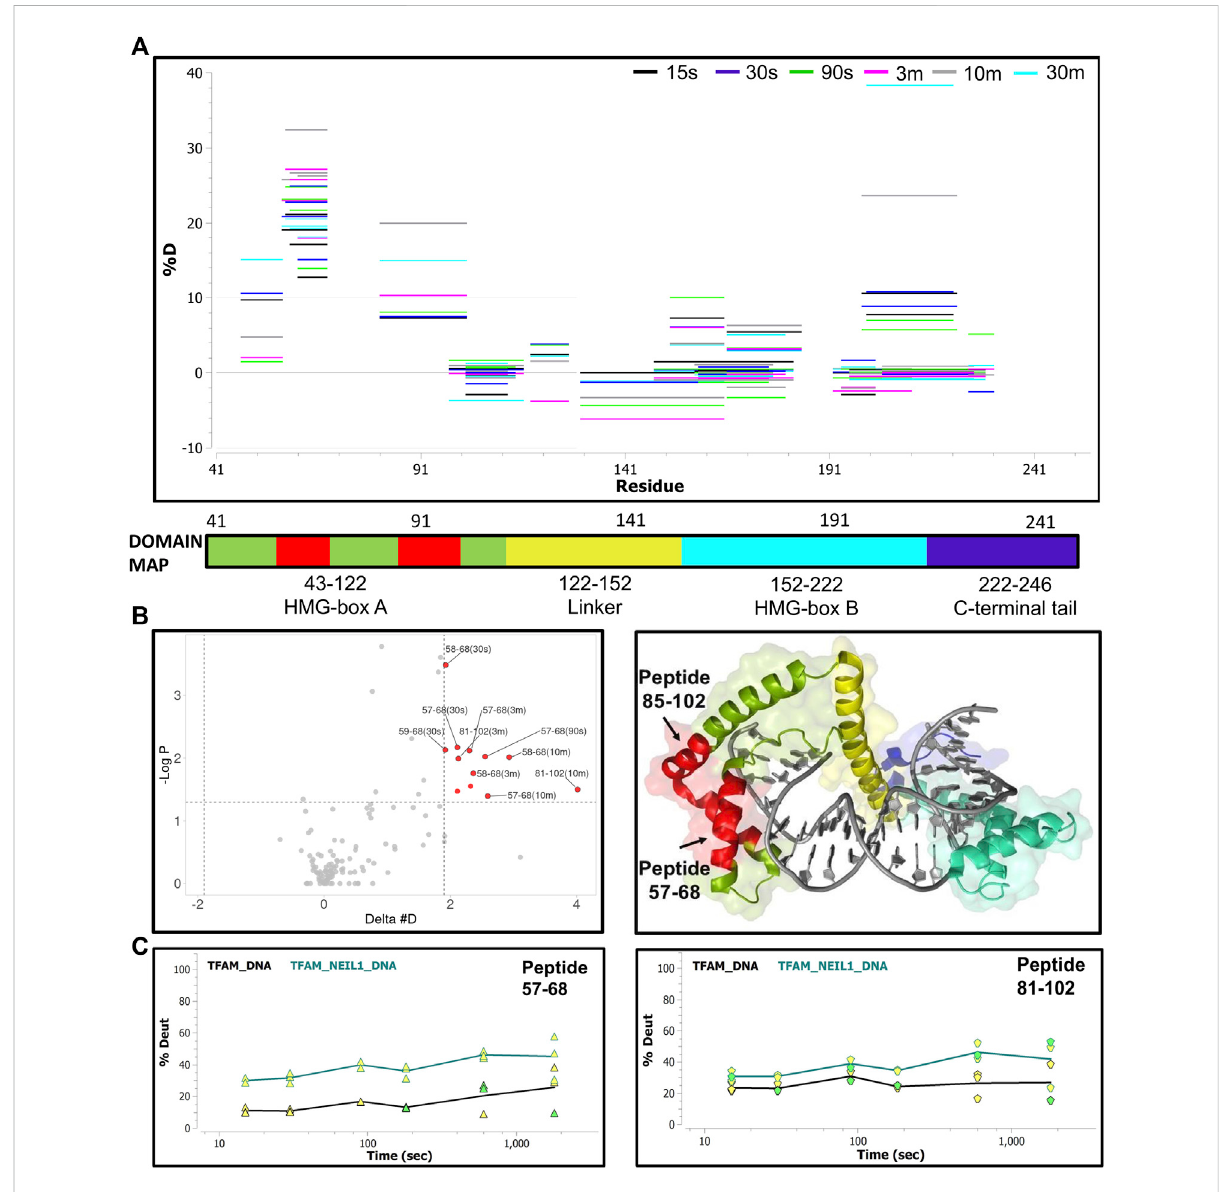
FIGURE 8 Hydrogen-deuterium exchange analysis of the TFAM-DNA and TFAM-NEIL1-DNA complexes reveals putative TFAM regions that interact with NEIL1inthepresenceofDNA. (A) Woodsplotrepresentingpercentchangeindeuterationforpeptidesaftervarioustimepoints(15 s – 30 m)between the TFAM-DNA and TFAM-NEIL1-DNA complexes, where a positive percentage indicates more deuteration and less protection observed when NEIL1 is present within the TFAM-NEIL1-DNA complex. Each horizontal line in the plot represents an individual peptide with residue range on the X -axisanddeuterationleveli.e.,levelofprotectiononthe Y -axis. (B) VolcanoplotdisplayingTFAMpeptideswithastatisticallysigni fi cantincrease in deuteration ( p -value < 0.05; please refer to thelegend for Figure 5A for a detailed description of thestatistical tests used) in the TFAM-NEIL1-DNA complexindicatedassolidredcircles(leftpanel).Ontherightpanel,thepeptideswithasigni fi cantincreaseindeuterationaremappedonthecrystal structure of the TFAM-DNA complex (PDB ID:4nnu) and are highlighted in red. The domain map above also displays the two regions (red) that show thegreatestdifferenceindeuteriumuptakeupontheadditionofNEIL1. (C) RepresentativeuptakeplotsareshownfromtheHDX-MStimecoursefor peptides 57 – 68 and 81 – 102 that lie within the signi fi cance quadrant of the volcano plot in (B)